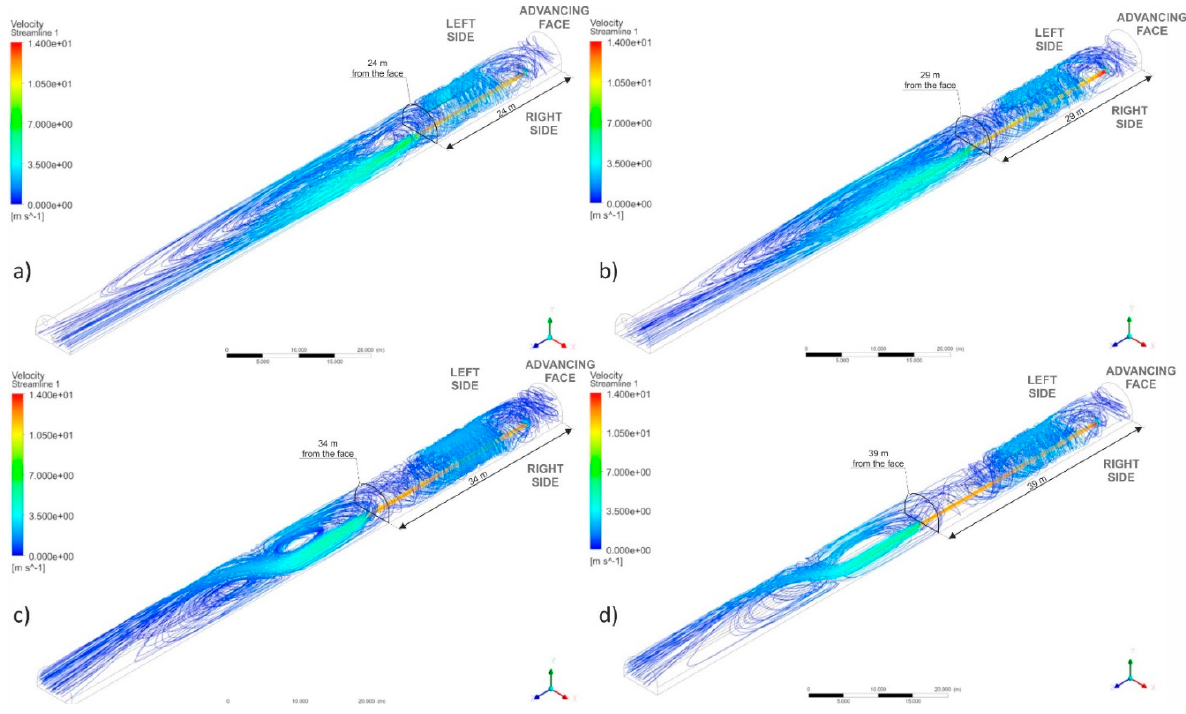
Figure 8. Velocity streamlines ( a ) L 0 = 5 m , ( b ) L 0 = 10 m , ( c ) L 0 = 15 m , ( d ) L 0 = 20 m.